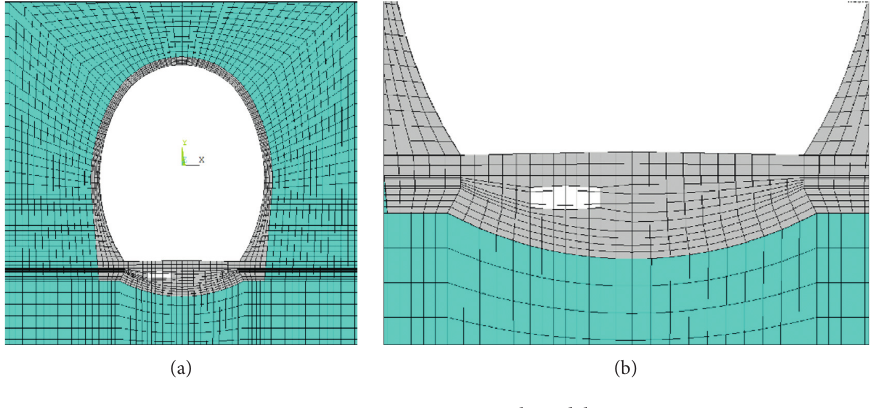
Figure 16: Computational model.